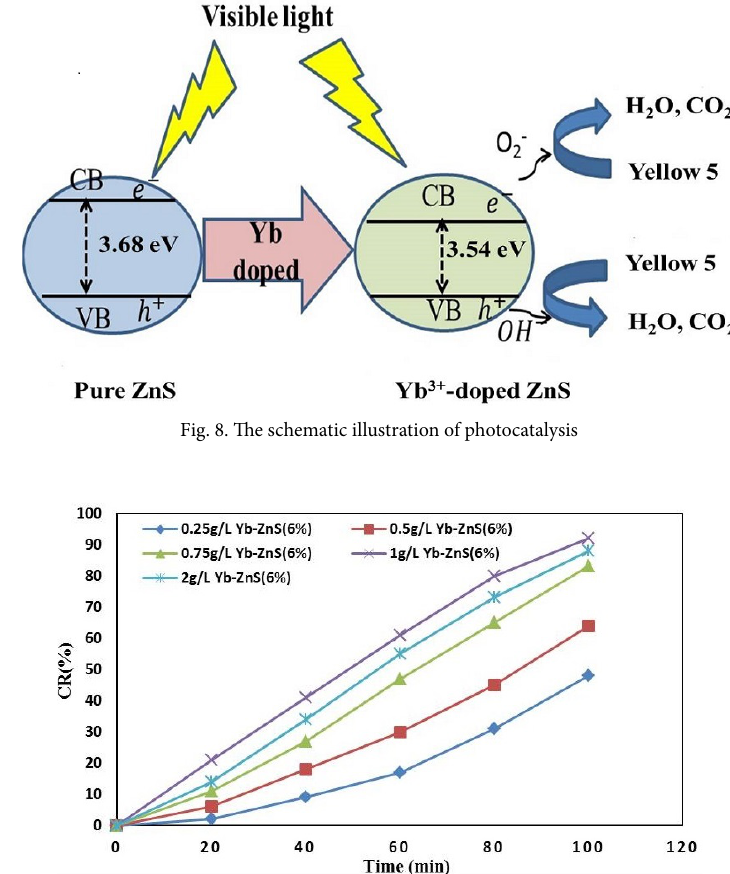
Fig. 9. Influence of catalyst loading on the decolorization of 10 mg/L Yellow 5 by the Yb